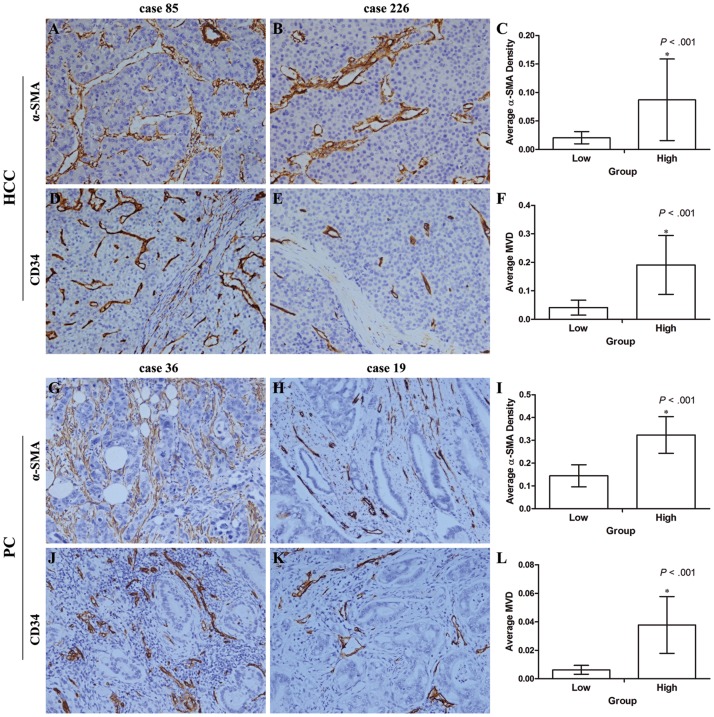
Representative high and low perivascular stromal cell densities and microvessel density (MVD) measured by immunostaining for alpha-smooth muscle actin (α-SMA) and CD34 in tissue microarrays of hepatocellular carcinoma (HCC) and pancreatic cancer (PC).Case 85 (HCC) and PC case 36 showed high α-SMA density (A, G) and MVD-CD34 values (D, J); whereas, HCC case 226 and PC case 19 showed low α-SMA density (B, H) and MVD (E, K) (×200). (C, F, I, L) Average α-SMA density and MVD of high or low risk groups in HCC and PC. *Independent samples t test showed a statistical difference between the two groups.